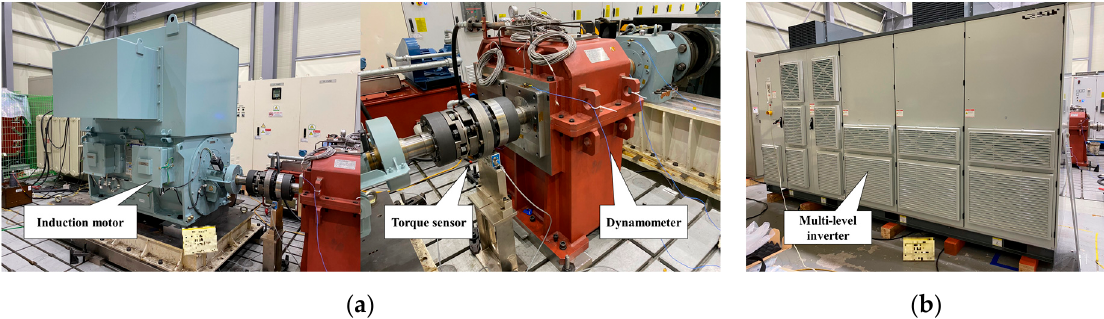
Figure 3. Experimental setups for performance evaluation of the EMDS. ( a ) Induction motor and dynamometer; ( b ) multi- level inverter.